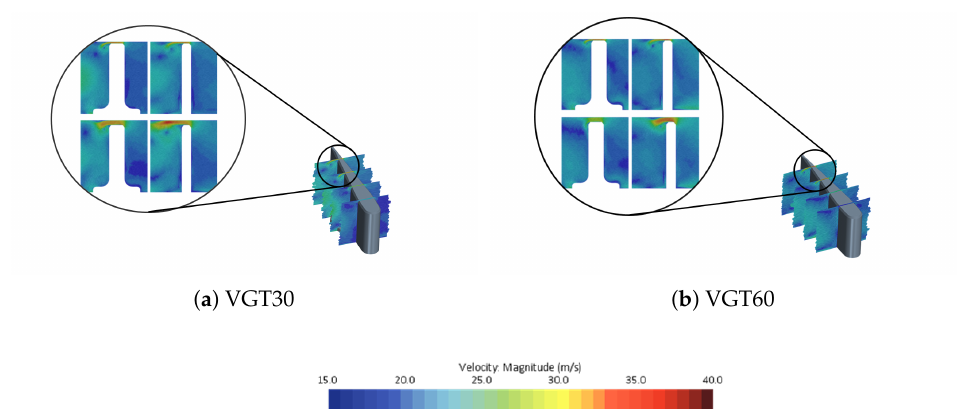
Figure 15. Velocity convoluted vectors for different chord lengths. ST; VGT30 and VGT60; 0.5 and 1.5 mm tip